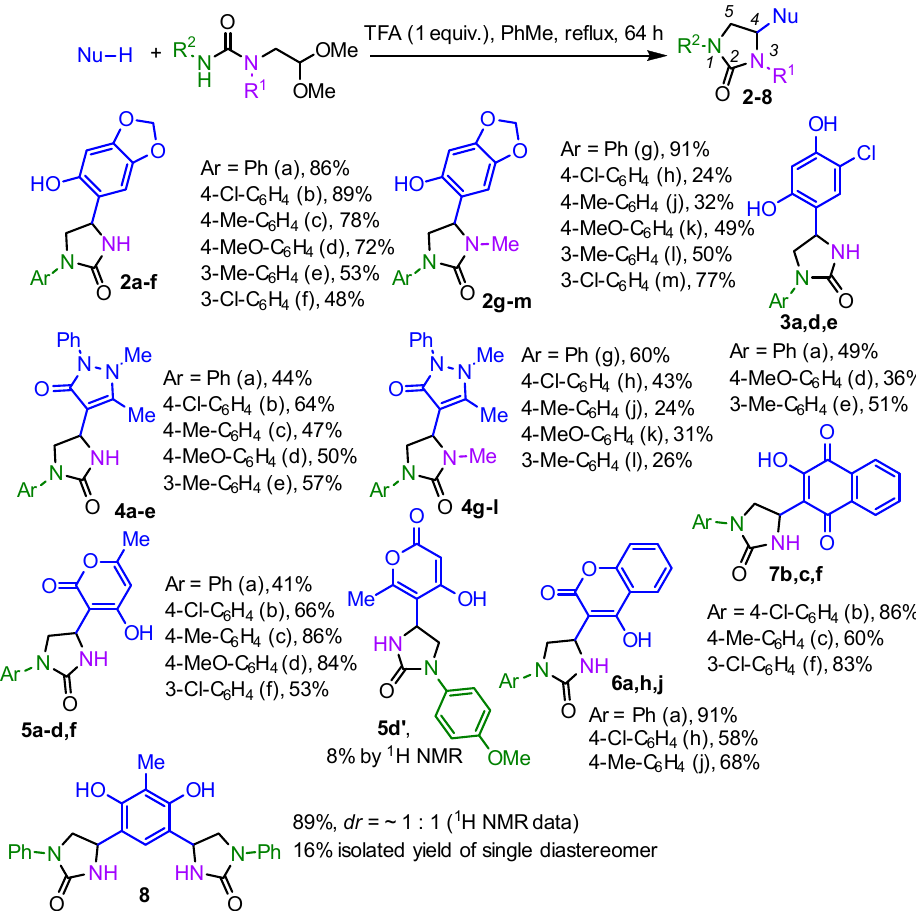
Scheme 3. The synthesis of imidazolidine-2-ones 2. The isolated yields are given, unless noted otherwise. The chemical shifts of methyne and methylene protons for 4- and 5-substituted imidazolidin-2-ones differ notably [19] (see Supplementary Materials, Figure S2). Thus, the substitution site of the imidazolidinone ring for the N -methyl substituted compounds 2h – m and 4h – l was determined by the comparison of their NMR spectra with the spectra of previously described 4-substituted imidazolidin-2-ones, 2g and 4g [19] (for example, see Supplementary Materials, Figures S3 and S4). Additionally, the structures of the compounds 2j and 2k were confirmed by X-ray analysis (Figure 2; for details, see Supple- mentary Materials, pp. S2–S3 and Figure